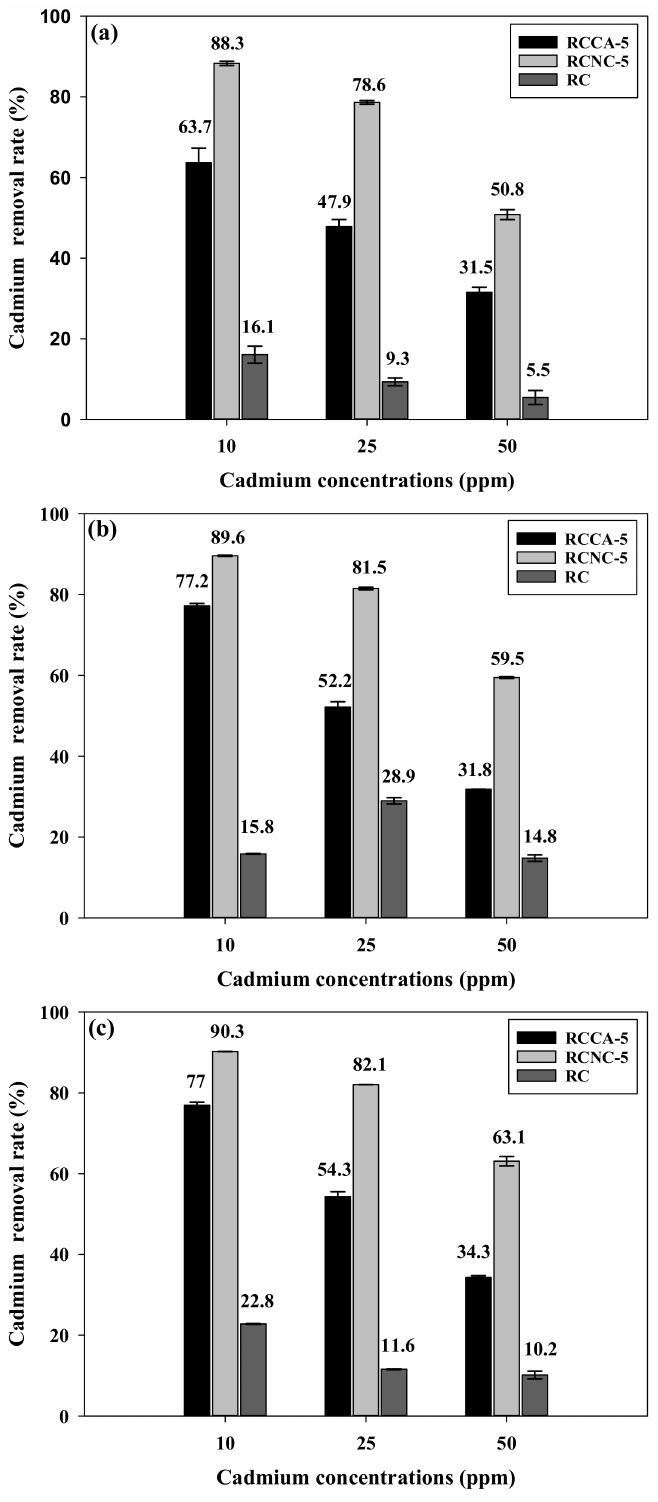
Figure 6. Cadmium removal rate by the manufactured composites (RCCA-5, RCNC-5) and RC, according to the heavy metal concentration at the reaction time of 120 min, at ( a ) pH 4, ( b ) pH 5, and ( c ) pH